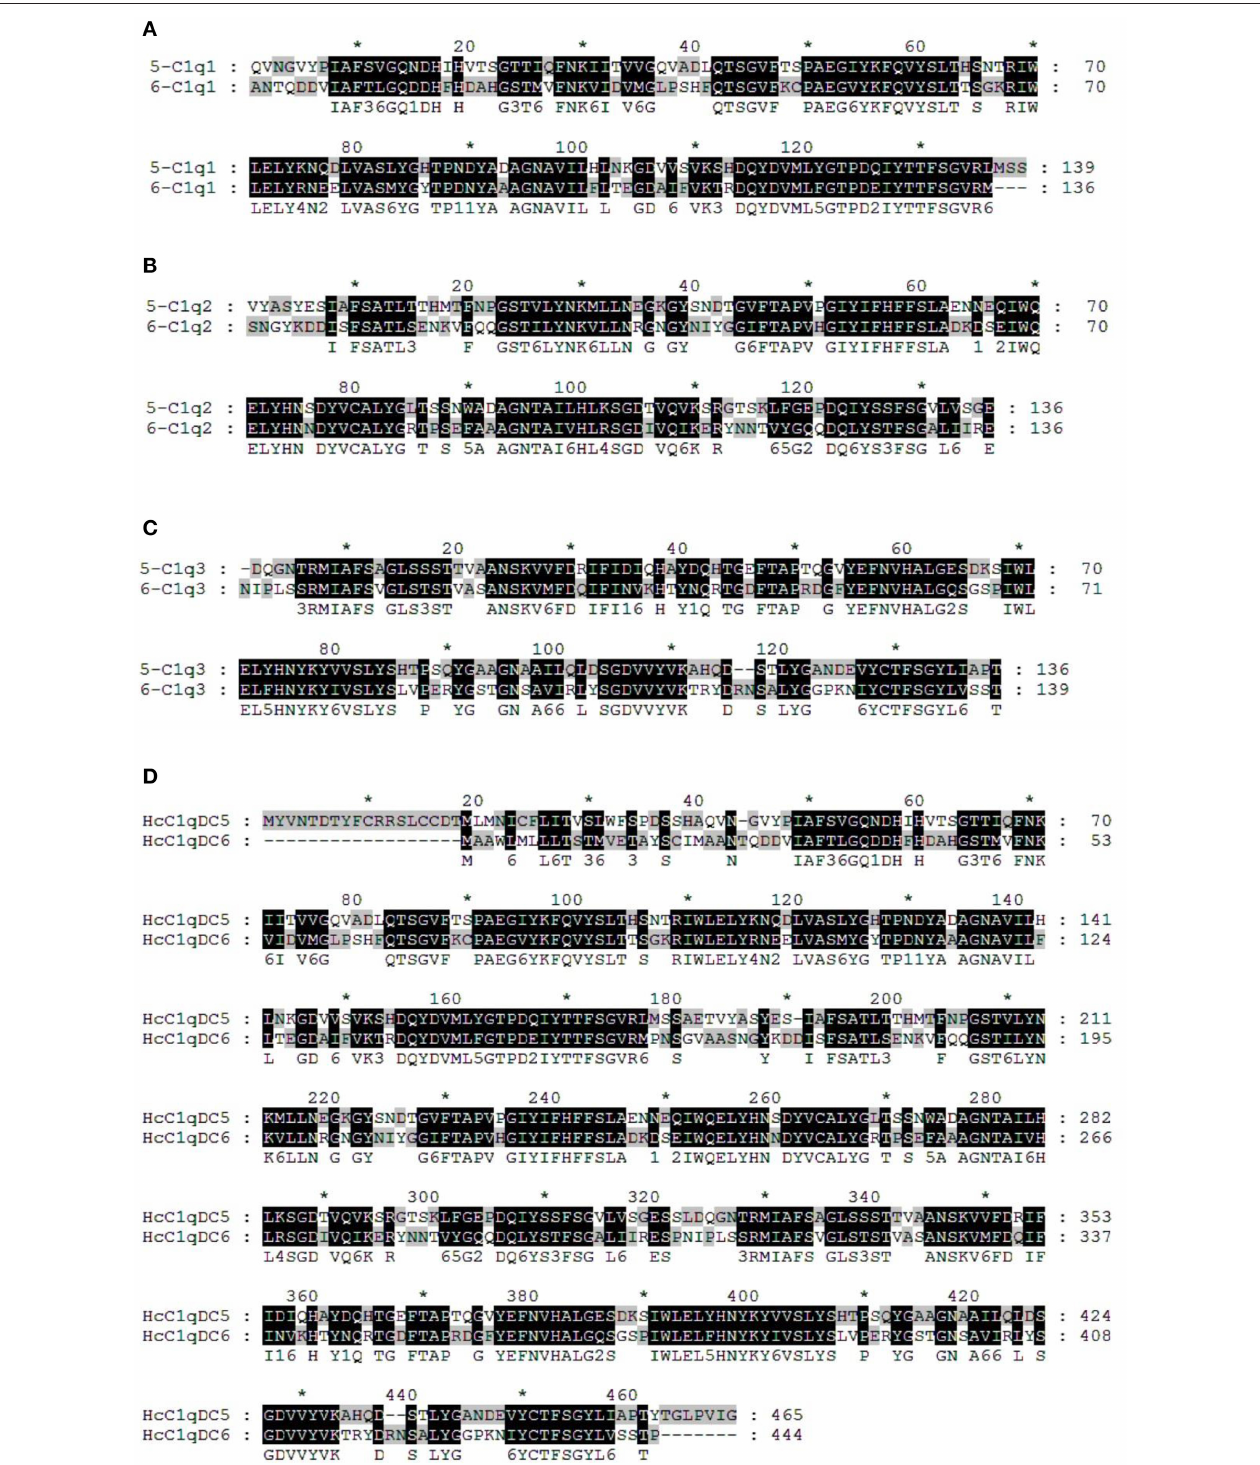
FIGURE 2 | Multiple alignment analyses of the first C1q domain (A) , the second C1q domain (B) , the third C1q domain (C) , and the full length amino acid sequences (D) of HcC1qDC5 and HcC1qDC6.